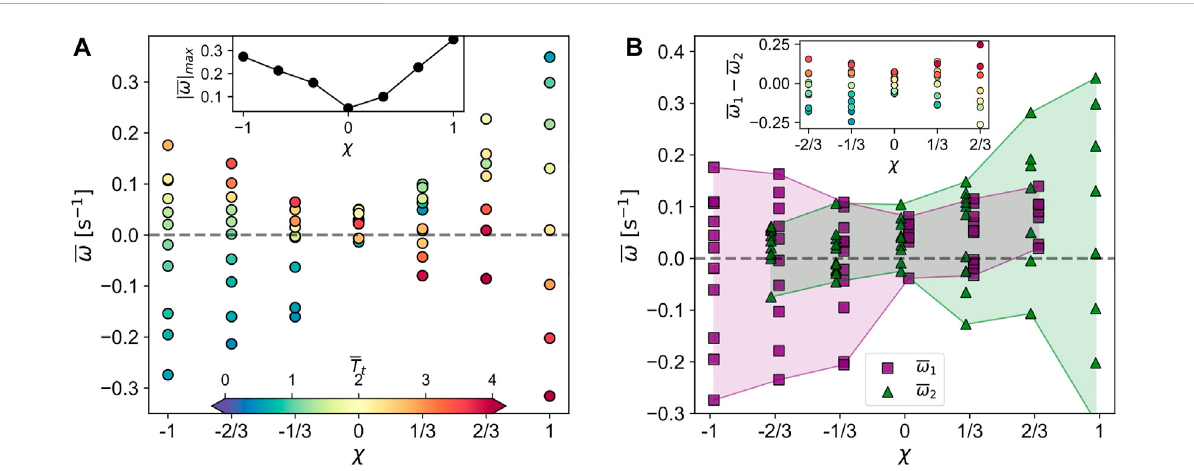
FIGURE 6 (A) Evolutionofthevorticityasafunctionof χ and T t ,absolutevaluesintheinset. (B) Partialvorticitiesofeachspecies,purplefortype-1particles and green for species-2 spinners.